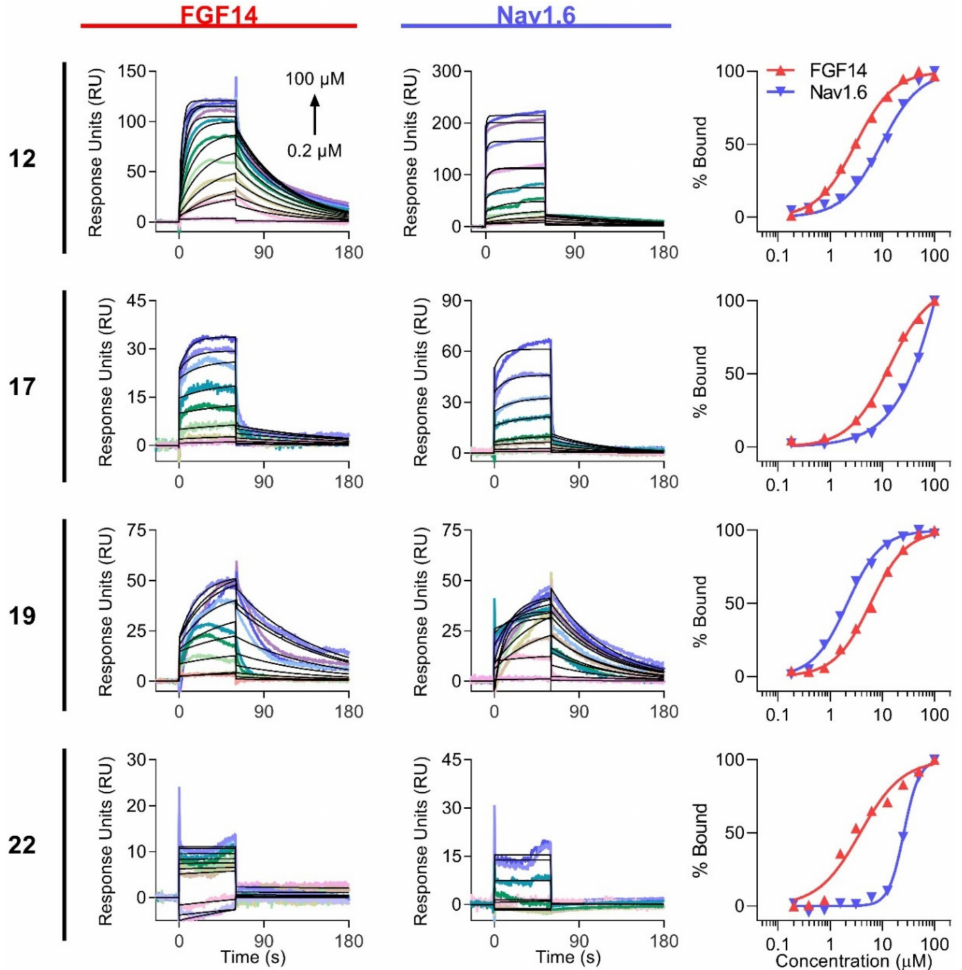
Figure 4. Determination of peptidomimetic binding kinetics to FGF14 and Nav1.6 C -terminal tail by SPR. Increasing concentrations of peptidomimetics (0.195–100 µ M) were flown over purified FGF14 or Nav1.6 C -tail protein bound to CM5 chips using a flow rate of 60 µ L / min. Kinetic analysis of each ligand / analyte interaction was obtained by fitting the response data to the simplest Langmuir 1:1 interaction model (K D = k o ff / k on ), and binding sensorgrams are shown for FGF14 ( left ) and Nav1.6 ( middle ), with fitted curves represented in black. Steady-state saturation plots ( right ) are shown for comparison of compound binding to FGF14 (red) and Nav1.6 (blue), with response units (RU) normalized to the maximal binding response. The resulting equilibrium dissociation constants (K D ), as well as kinetic association (k on ) and dissociation (k o ff ) rates, are provided in Table 3. Consistent with the SAR studies using the LCA, which revealed that modification of 17 (cid:48) s R 2 substituent from Ac to benzoyl ( 19 ) improved e ffi cacy (Table 2), this modification also resulted in an approximately 2-fold increase in binding to FGF14 and a 4-fold increase in binding to Nav1.6. Kinetically, this improved binding a ffi nity was mediated via the benzoyl substitution conferring slower association and dissociation rates toward both proteins (as depicted by greater curvature in the SPR sensorgrams), a change likely attributable to the substituent’s constitutive π bonds enabling additional interactions with both binding partners. Overall, given 19 (cid:48) s heightened e ffi cacy and binding a ffi nities toward both FGF14 and Nav1.6 relative to the other potential PAMs ( 17 and 22 ), it, along with the potential NAM ( 12 ), were selected for functional